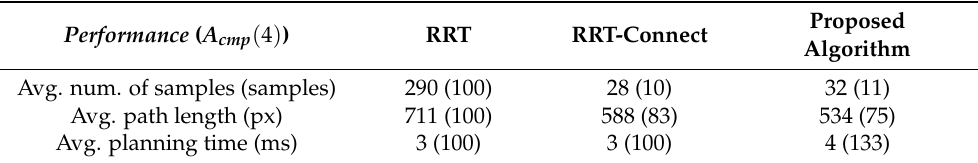
Table 5. Experimental result of Map 4 (The parentheses to the right of each value are relative ratios based on RRT 100% ( x cmp ( 4 )